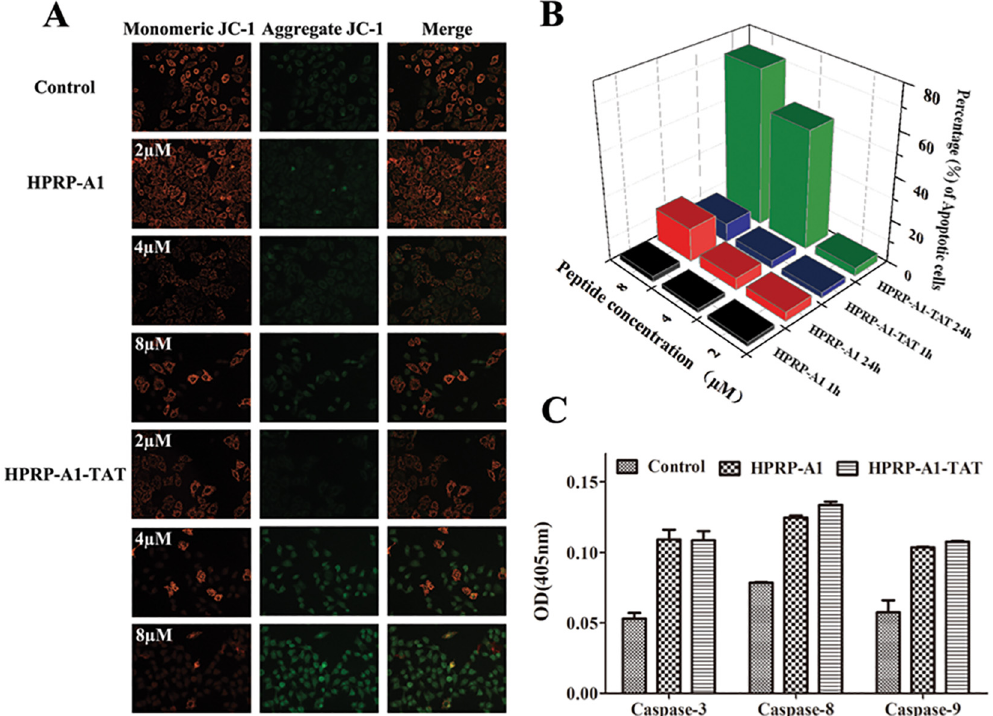
Fig 3. Peptide-induced cell apoptosis. ( A ) Mitochondrial membrane potential measured by JC-1, an indicator of mitochondrial function. HeLa cells were treated with various concentrations of HPRP-A1 or HPRP-A1-TAT for 24 h. ( B ) Percentage of early apoptotic cells, as assessed by flow cytometry. HeLa cells were treated with various concentrations of HPRP-A1 or HPRP-A1-TAT for 1 or 24 h. ( C ) Caspase-3, -8, and -9 activity. HeLa cells were treated with HPRP-A1 (4 μ M) or HPRP-A1-TAT (4 μ M) for 24 h before measuring caspase activity levels. Data are presented as the mean ± SD of three independent